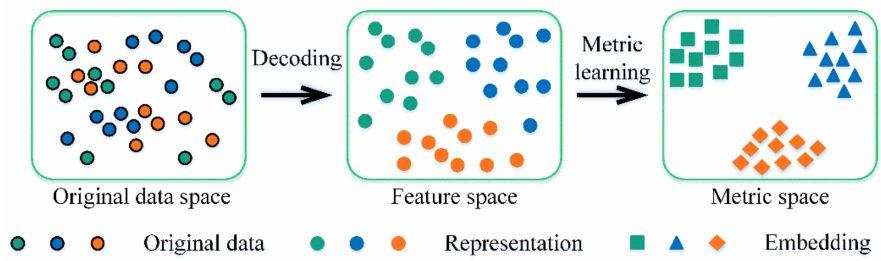
Figure 2. Deep metric learning.